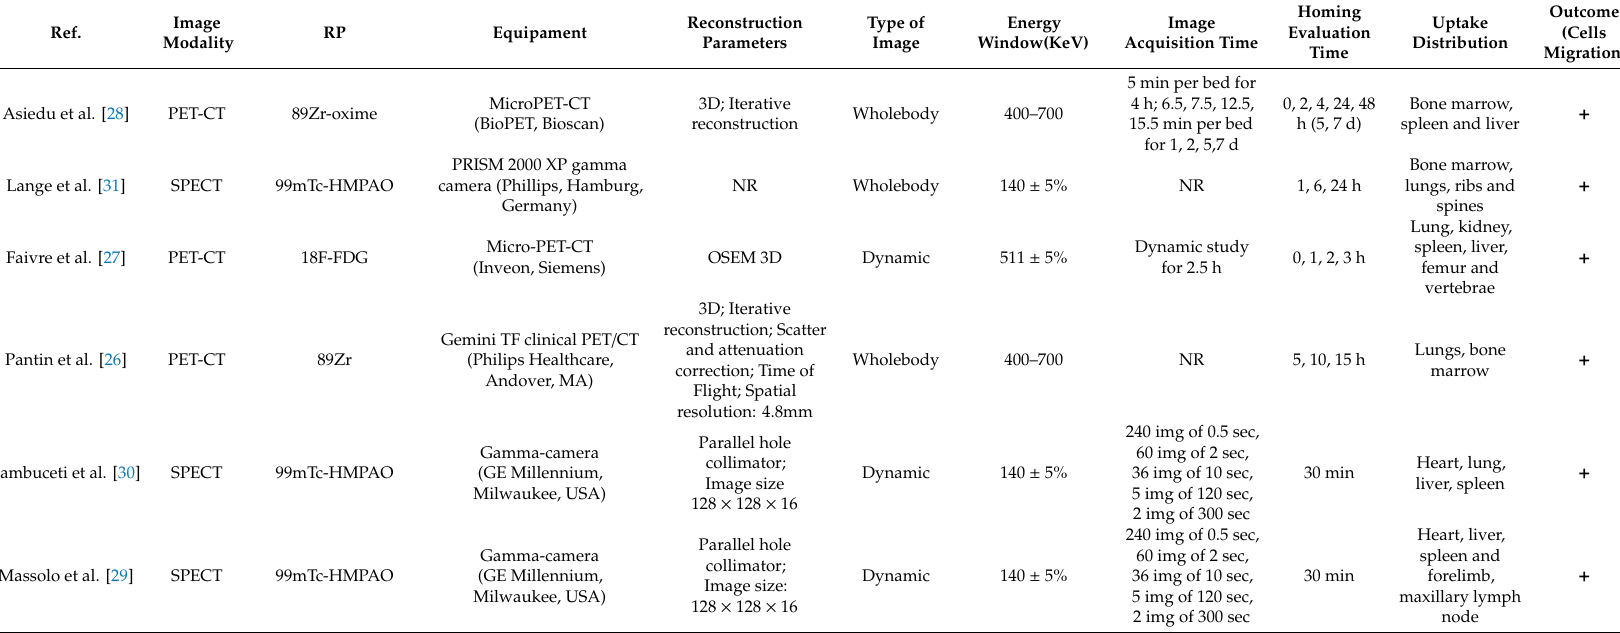
Table 8. HSCs migration homing and tracking by PET /